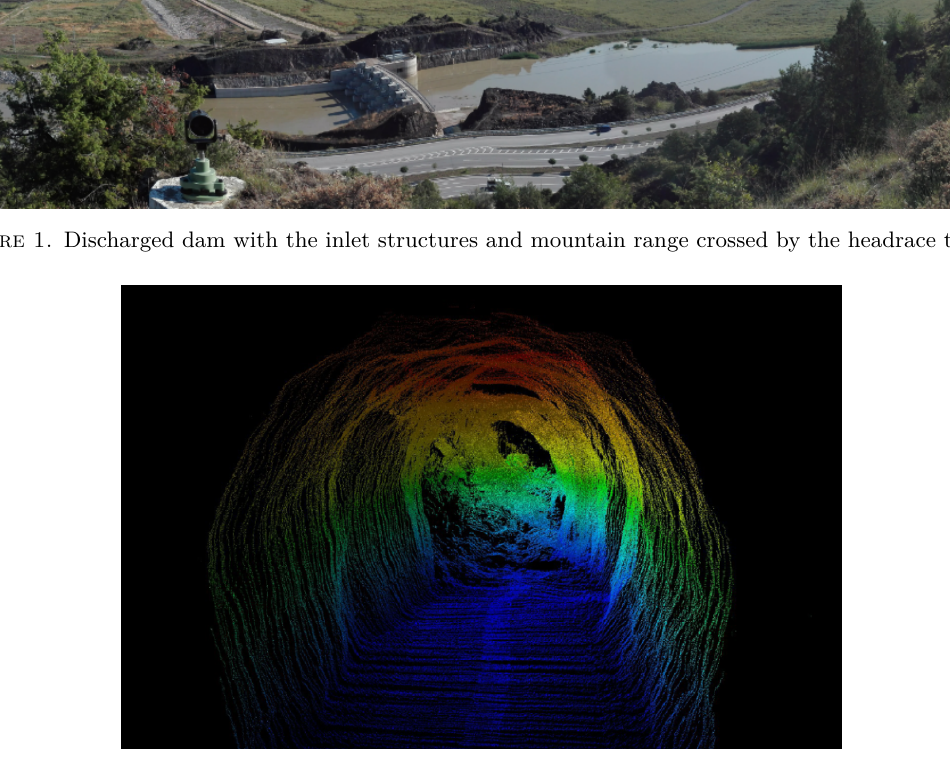
Figure 2. Record from scanning of collapsed area by